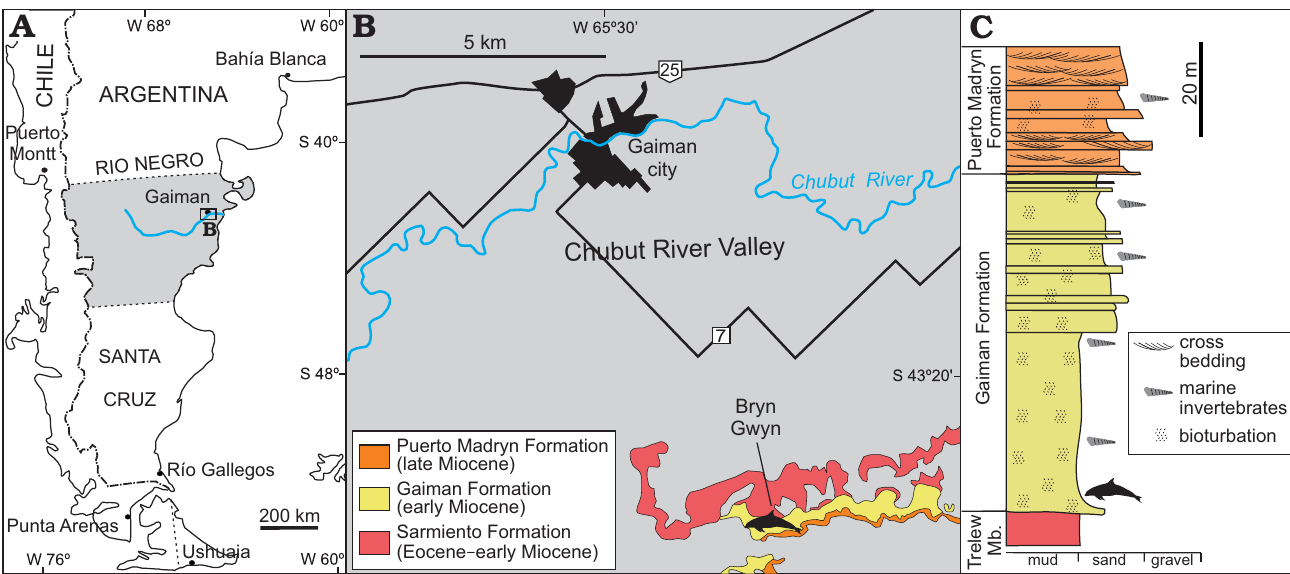
Fig. 1. Map and stratigraphic section of Bryn Gwyn, the type locality of Aondelphis talen gen. et sp. nov. A . Regional map of the study area. B . Detailed map with stratigraphic information of the type locality (dolphin outline). C . Simplified stratigraphic section of Bryn Gwyn, modified from Scasso and Bellosi (2004). Dolphin outline indicates type horizon of Aondelphis talen gen. et sp. nov. Trelew Mb., Trelew Member of Sarmiento